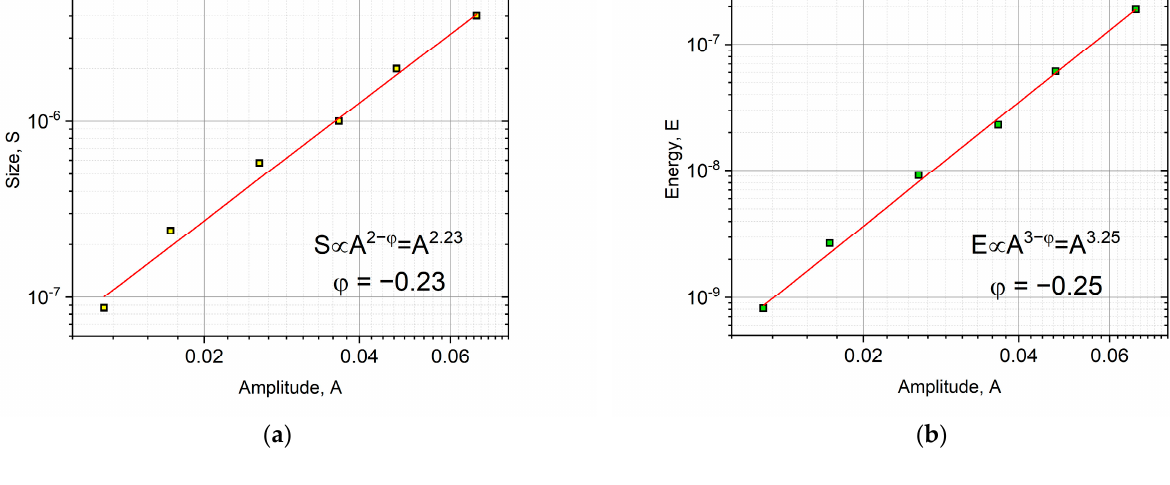
Figure 9. 𝑆 versus 𝑇 (cid:3082) function, fitted in the range of the average avalanche shape functions, result- ing γ = 1.65, which is in very good agreement with the γ value obtained from the fit of the average avalanche shapes.